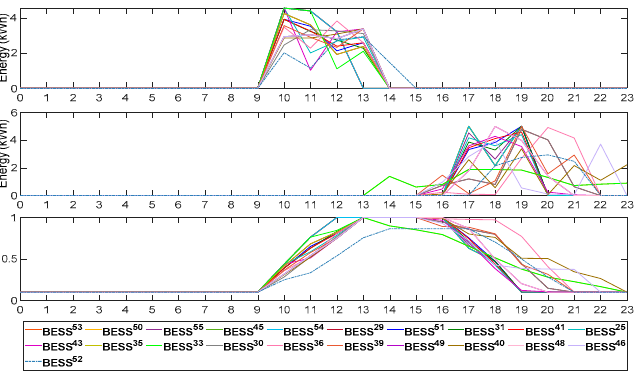
Figure 7. Stored energy, supplied energy, and SOC for each BESS when coordinated for over/undervoltage